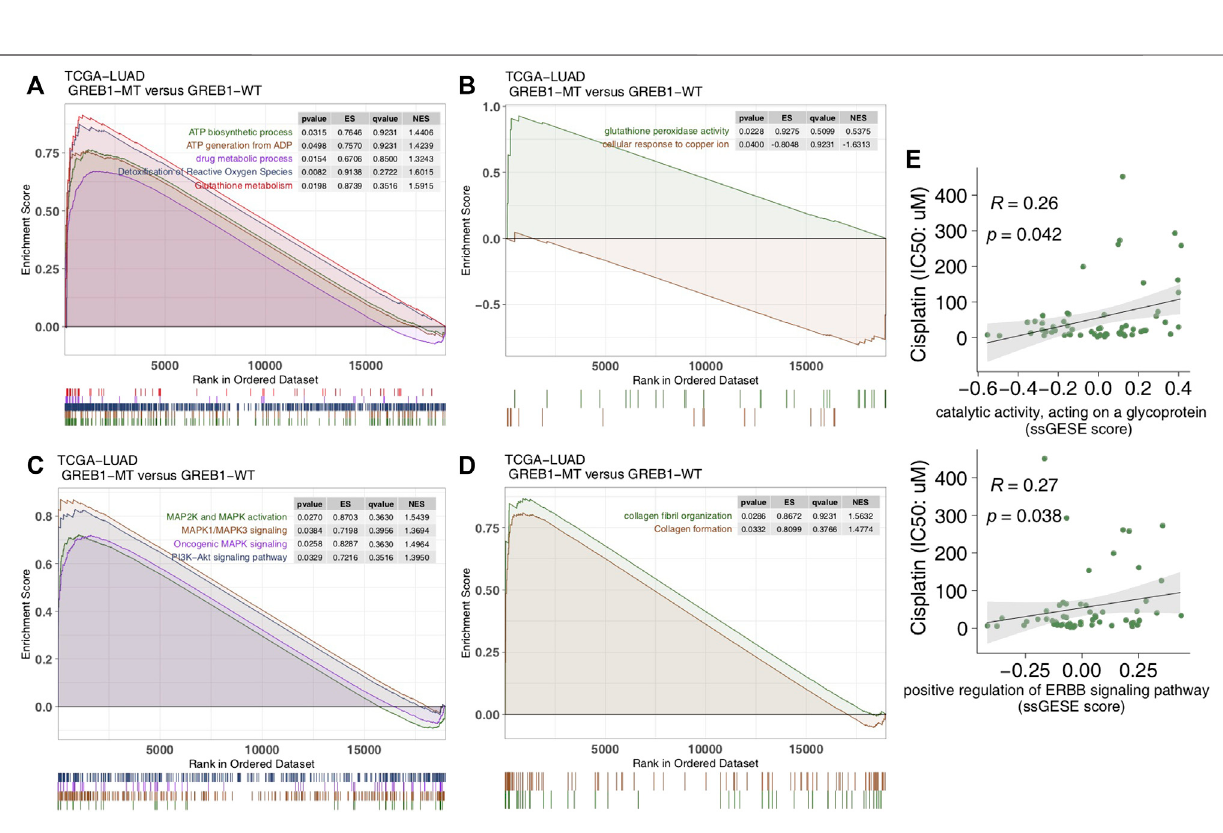
Frontiers in Pharmacology |